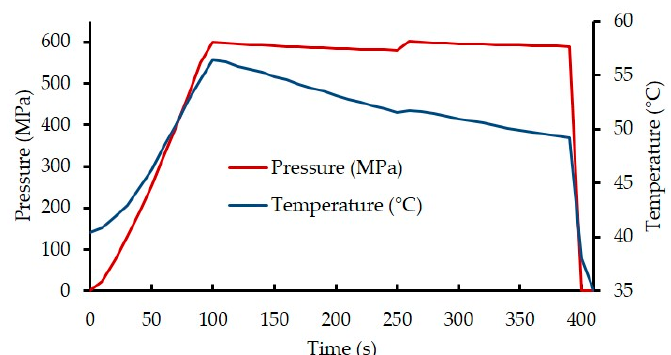
Figure 1. Temperature-pressure profile in alpha-lactalbumin ( α -Lac)-added reconstituted infant milk formula (IMF): High pressure processing (HPP) applied at 40.4 °C/600 MPa for 5 min.